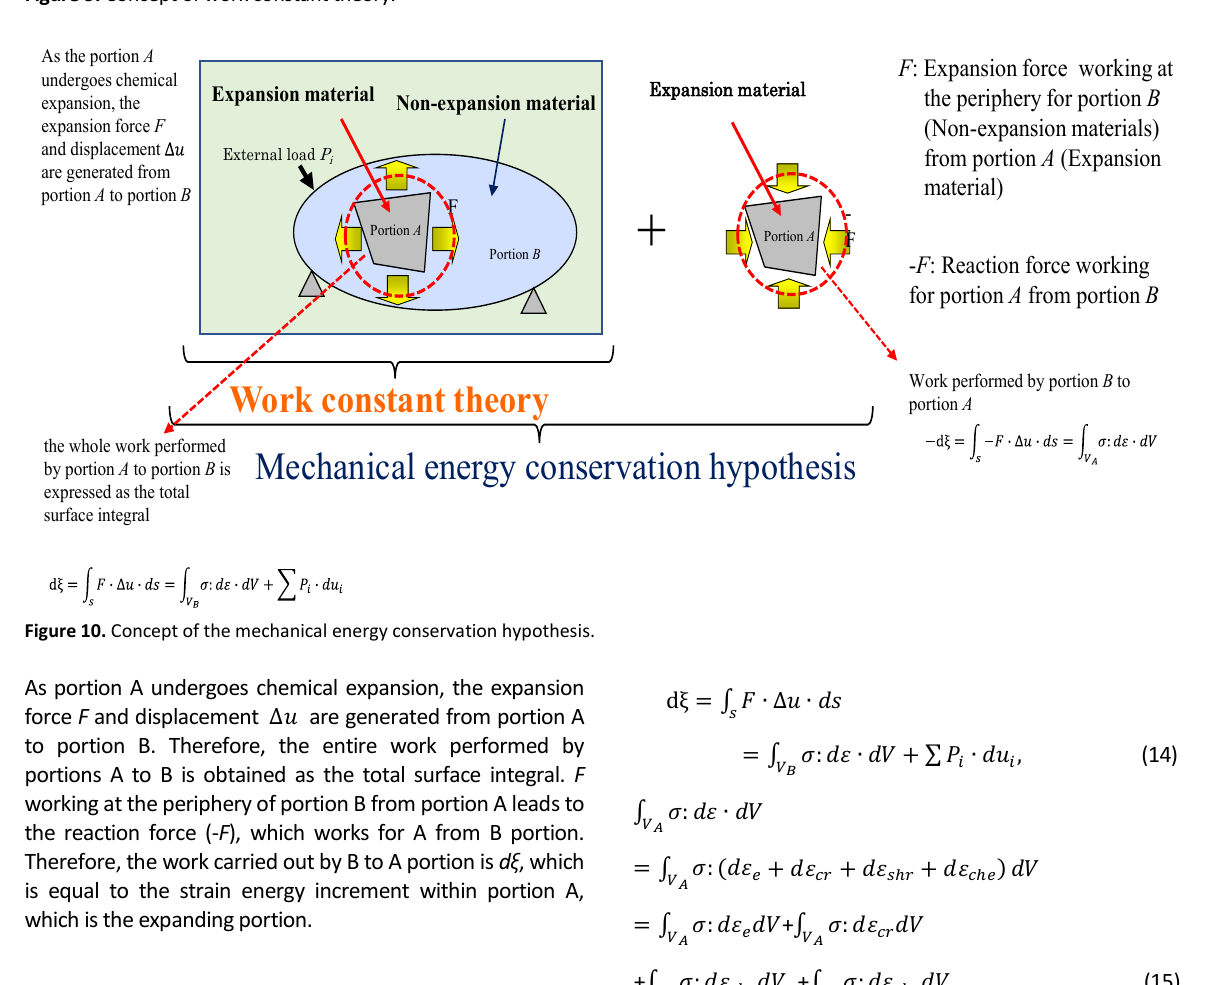
Figure 9. Concept of work constant theory.